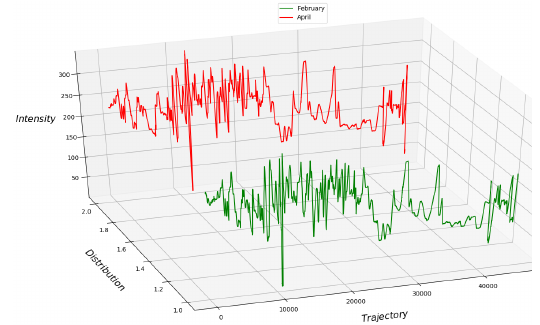
Figure 18. Virtual probable light signatures for trajectory ti to Deva (via , segment Pites ti to Deva (via Sibiu) with SL=20 and ρ ,